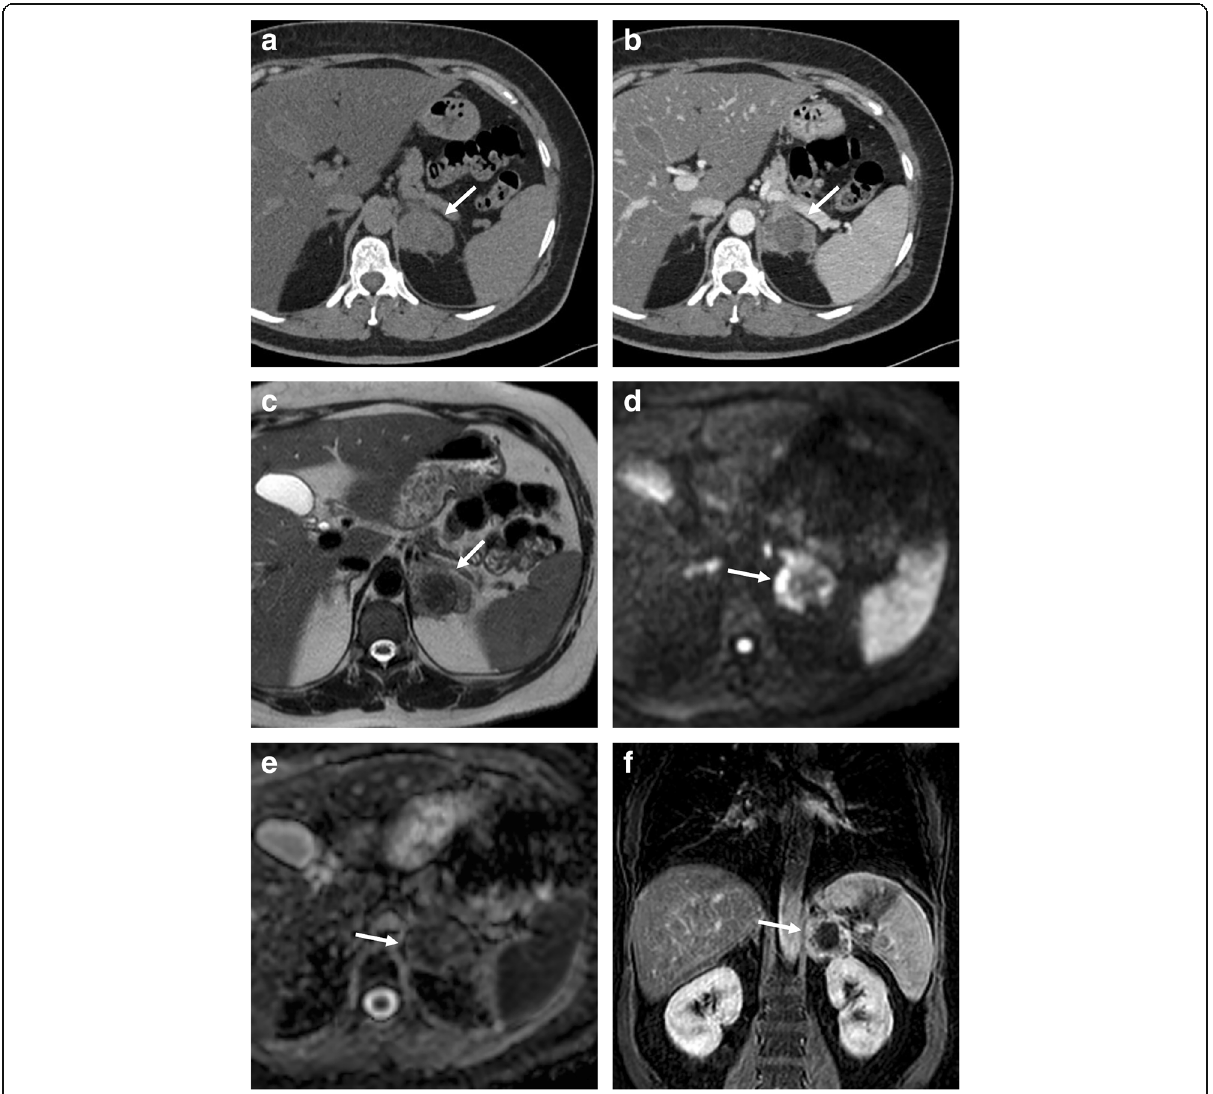
Fig. 11 Left adrenal metastasis in a 58-year-old woman with breast cancer. Axial unenhanced CT ( a ), portal phase ( b ), T2-weighted fast spin echo ( c ), b800 s/mm 2 diffusion-weighted image ( d ), ADC map ( e ), and coronal three-dimensional fat-suppressed T1-weighted gradient recalled echo image in portal phase after contrast injection ( f ) show a left adrenal mass (arrow). This lesion intra-lesional hemorrhage presenting as spontaneously hyperdense area on unenhanced CT ( a ), hypointense on T2-weighted ( c ), and no enhancement on CT ( b ) and MR ( f ) images after contrast injection. The peripheral solid component of the lesion shows also restricted pattern of diffusion ( d , e